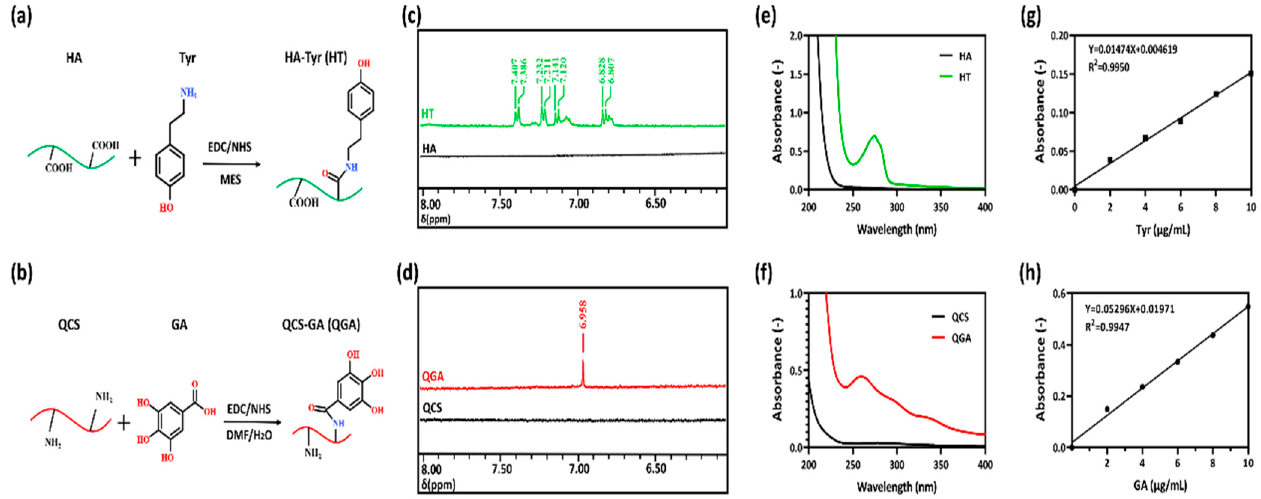
Figure 1. Synthetic scheme of ( a ) hyaluronic acid-tyramine (HT) and ( b ) quaternized chitosan-gallic acid (QGA) conjugate; ( c ) 1 H NMR spectra of HA and HT conjugate; ( d ) 1 H NMR spectra of QCS and QGA conjugate; ( e ) the UV-vis spectra of HA and HT; ( f ) the UV-vis spectra of QCS and QGA; ( g ) the standard curve of tyramine; ( h ) the standard curve of GA.